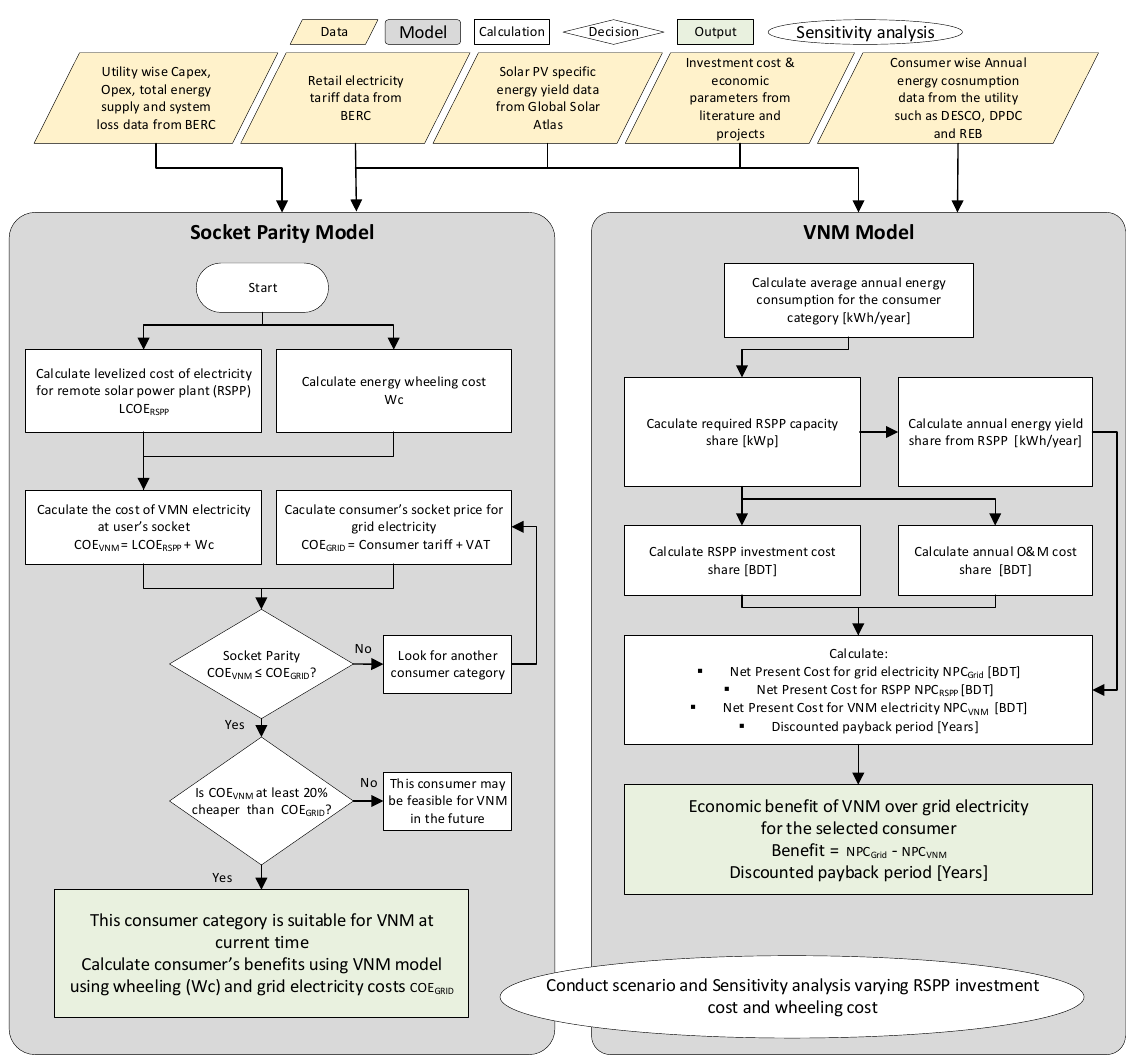
Figure 4. Overview of the research methods.